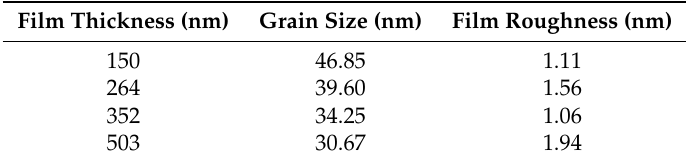
Table 2. Grain size and the film roughness values for NiO 0.96 thin films.